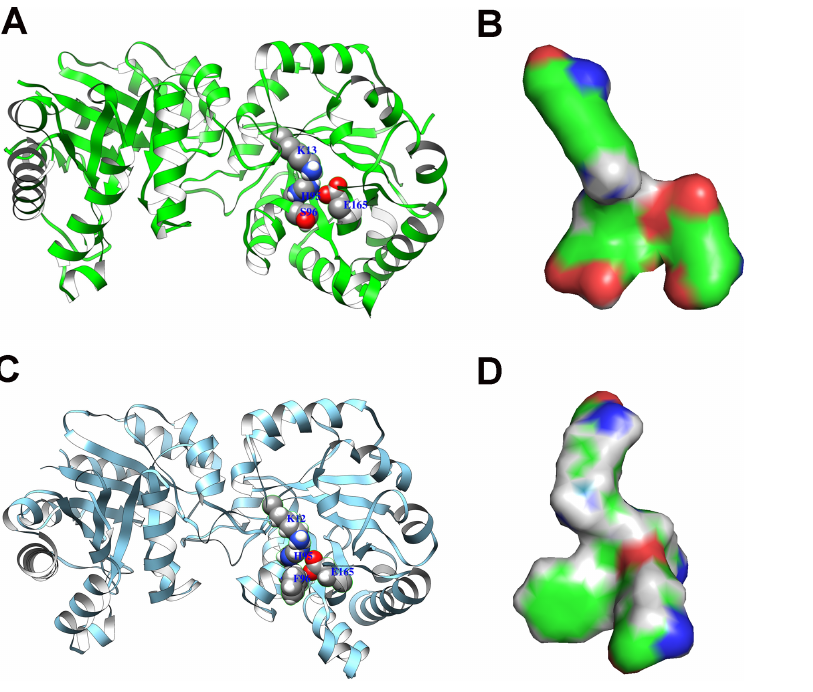
Figure 1 Active site residues TPI. (A) hTPI (green) structure with active site residues and (B) Elec- trostatic potential surface of hTPI active site. (C) pTPI (cyan) structure with active site residues and (D). Electrostatic potential surface of pTPI active site. Active site surface polarity variation in part due to substitution of S96 in hTPI-to F96 in